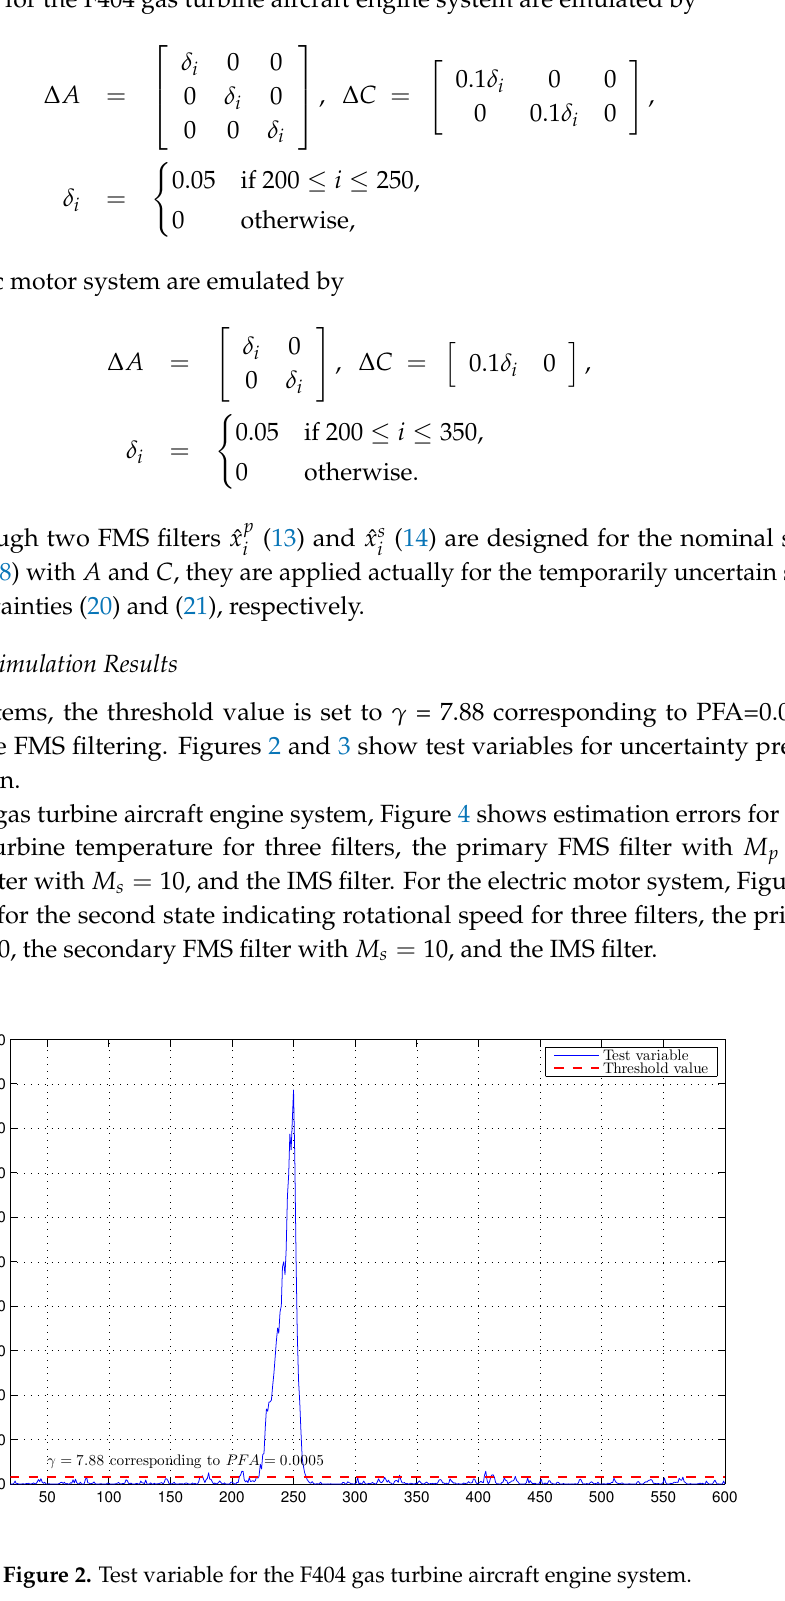
Figure 2. Test variable for the F404 gas turbine aircraft engine